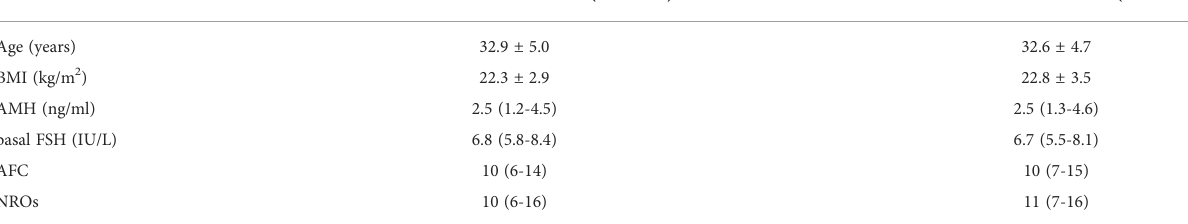
TABLE 1 Basic characteristics among women undergoing standard GnRH-antagonist